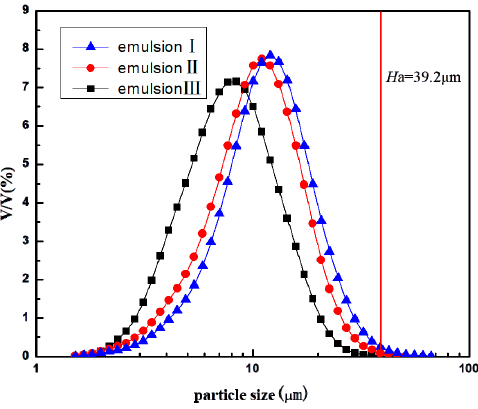
Figure 7. Droplet size distributions of I, II, and III emulsions.